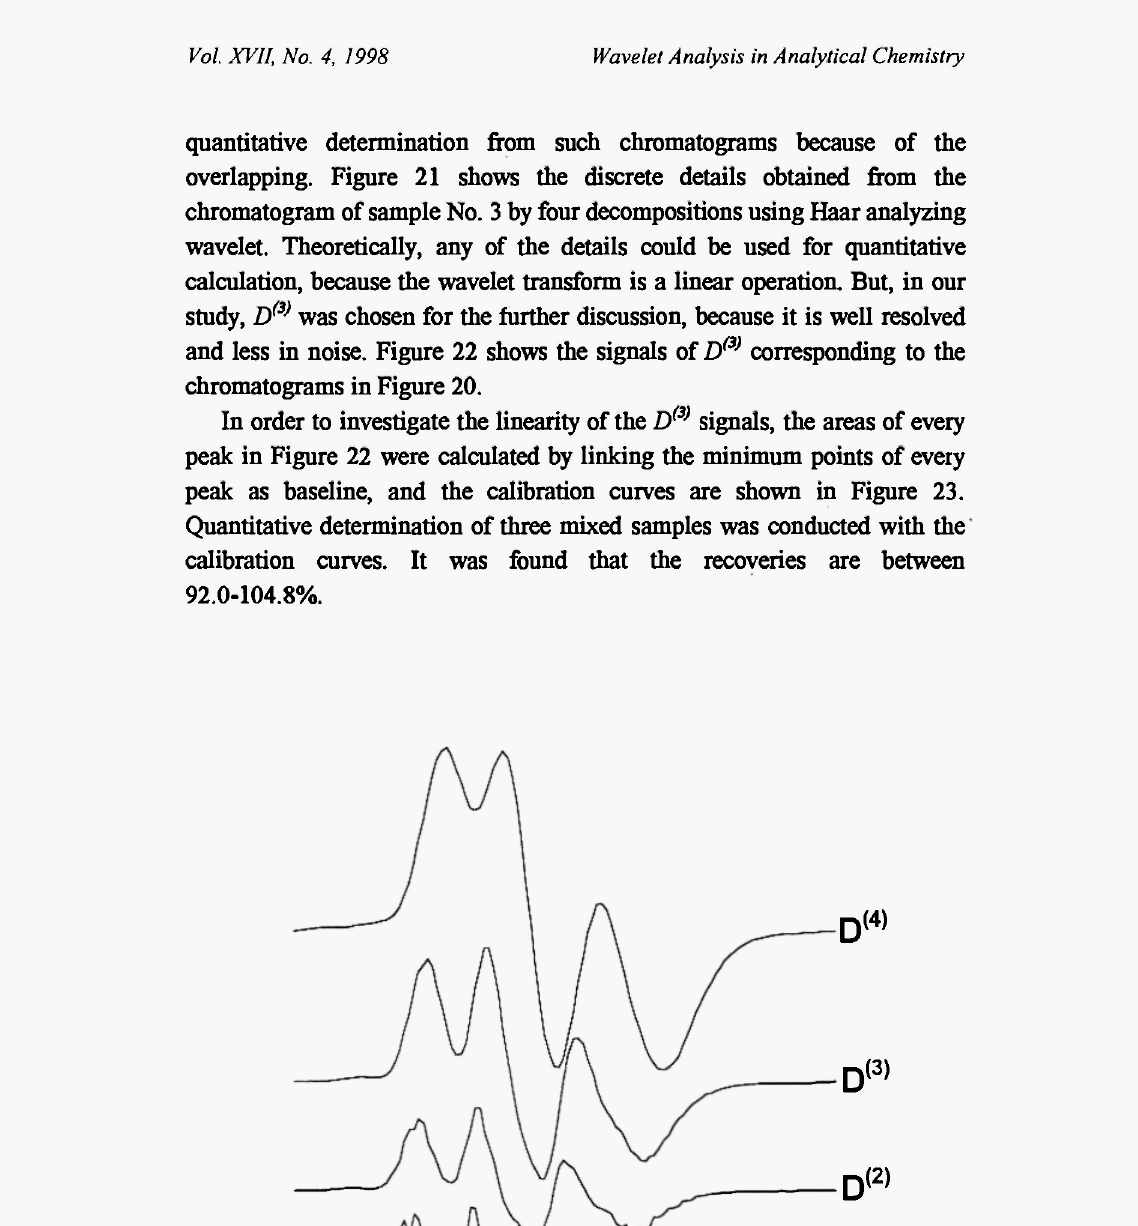
Fig. 21: The discrete details obtained by wavelet transform of sample